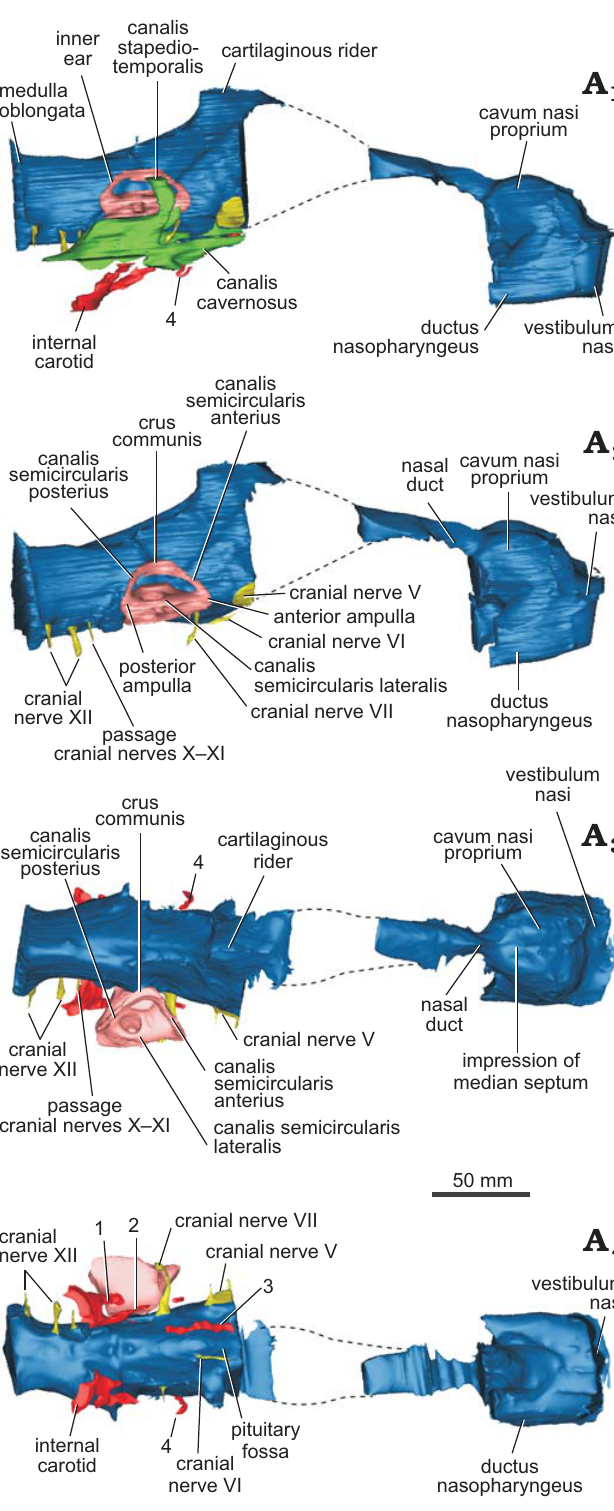
Fig. 2. Cranial endocast, nasal cavity, and inner ear (plus cavum acusti- co-jugulare, A 1 and blood vessels) of helochelydrid turtle Naomichelys speciosa Hay, 1908 (FMNH PR273) from the Early Cretaceous (Aptian/ Albian) Trinity Group, Texas; in right lateral (A 1 ), right posterolateral (A 2 ), dorsal (A 3 ), and ventral (A 4 ) views. 1, lateral branch of the internal ca- rotid artery; 2, anteromedial branch of the carotid artery; 3, cerebral artery; 4, ?unnamed branch of the nervi